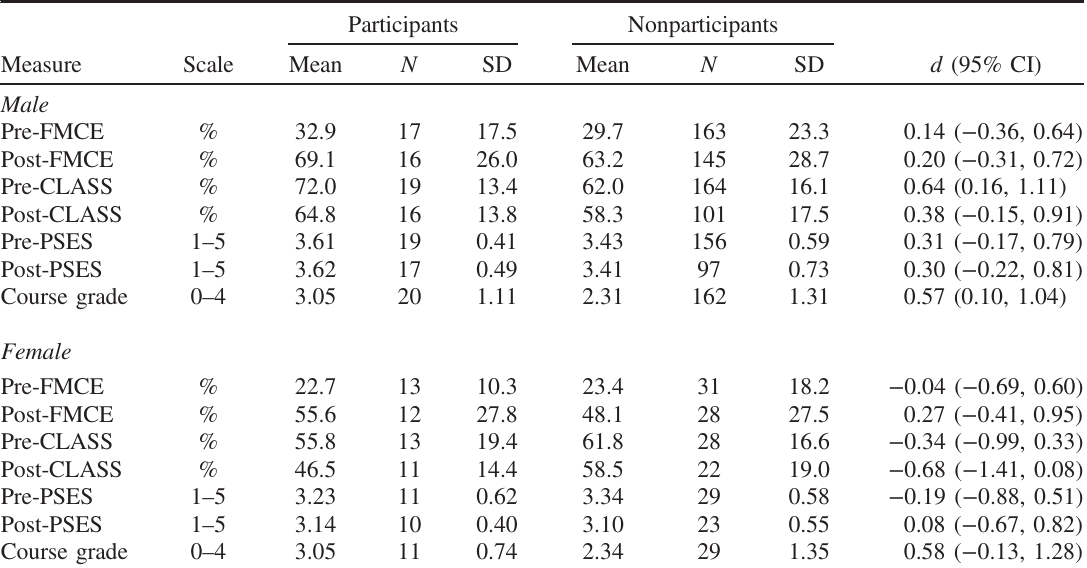
TABLE II. Representativeness of male and female ESM participants. Includes traits for ESM participants and nonparticipants by gender for all students who completed each trait